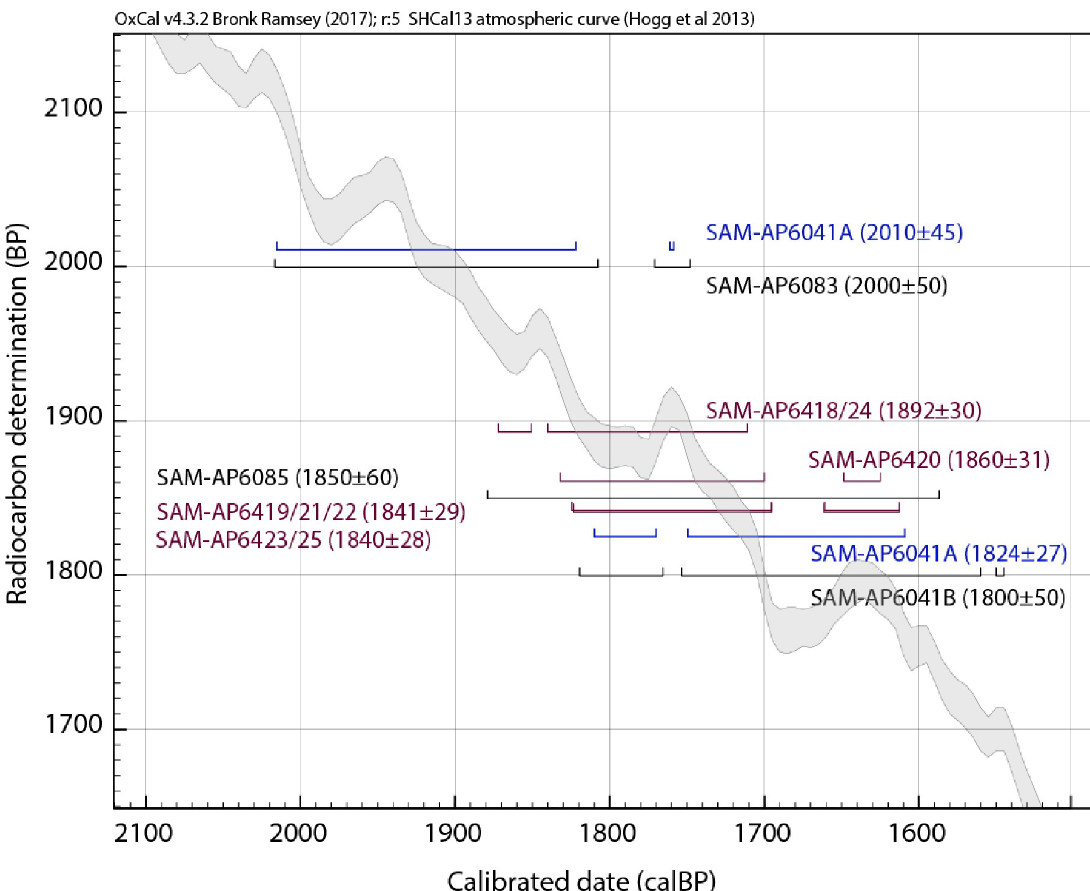
Fig 9. Nine radiocarbon ages for Lagoon Beach human remains. Calibrated using OxCal v. 4.3 and the atmospheric SHCal13 curve, shown in grey [78]. The two dates on individual SAM-AP6041A are in blue, and the four dates from the four individuals removed as a single unit in 1997 are in